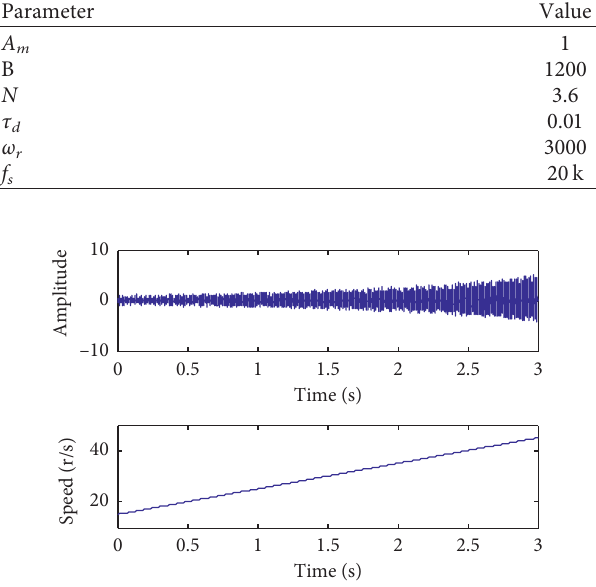
Figure 7: Simulation signal and